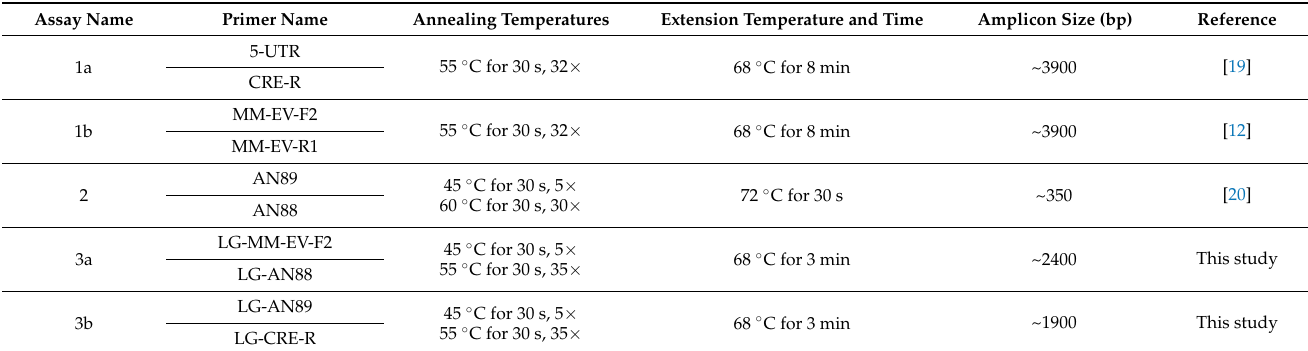
Table 1. Variation in assay conditions for the PCR assays used in this study. All primers listed have the same sequence as those listed in the references cited in the table. Please see Figure S6 for primer sequences. The LG prefix in primers for assays 3a and 3b implies the Loop Genomics adapter was added to the 5 (cid:48) -end of these